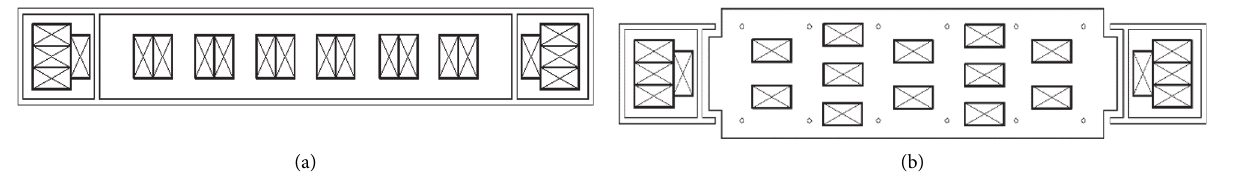
Figure 3: Weight scheme of the test model. (a) The primary structure. (b) Suspended floors.